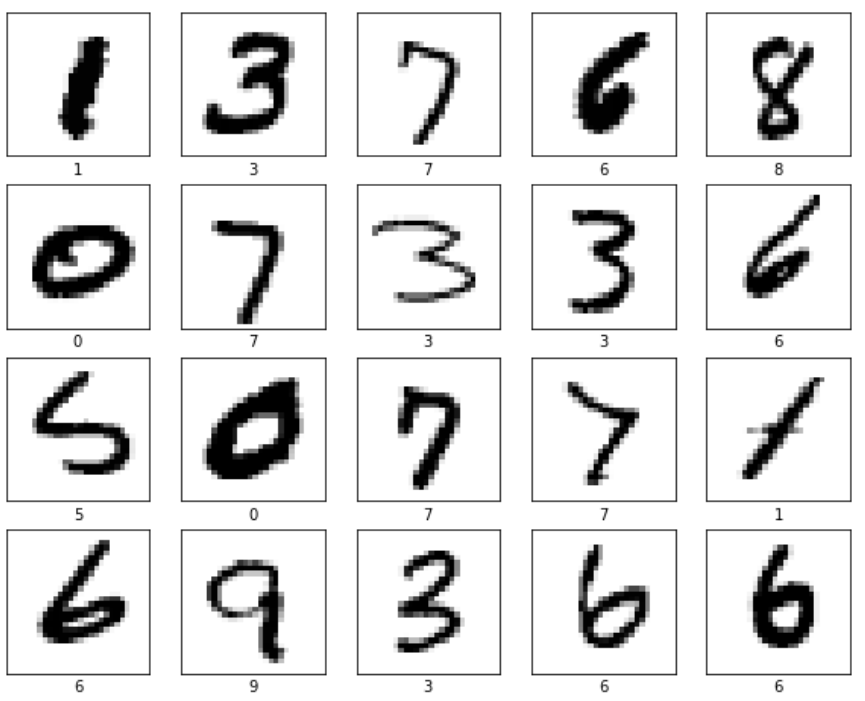
Figure 5. Handwritten numbers from the MNIST dataset [47].